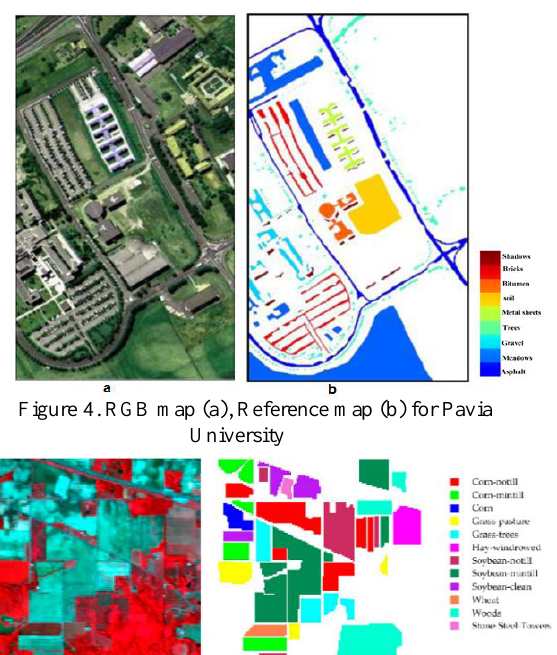
Figure 5. RGB map (a), Reference map (b) for Indian Pines The calibrated data are available online (along with detailed ground-truth information) and the second data set was acquired over an urban area in the city of Pavia, Italy. The data were collected by the reflective optics system imaging spectrometer (ROSIS) sensor, with 115 spectral bands in the wavelength range 0 . 43 − 0 . 86 μm and very fine spatial resolution of 1.3 m by